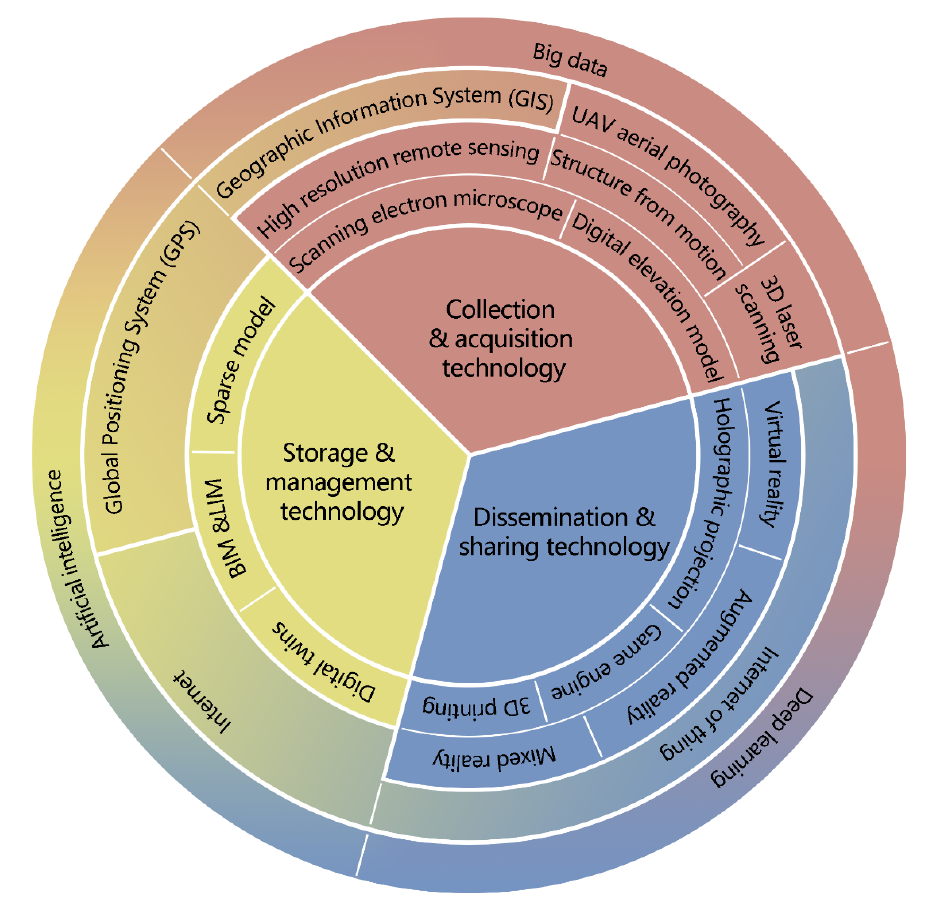
Figure 4. Classification map of digital technology in landscape architecture heritage protection.